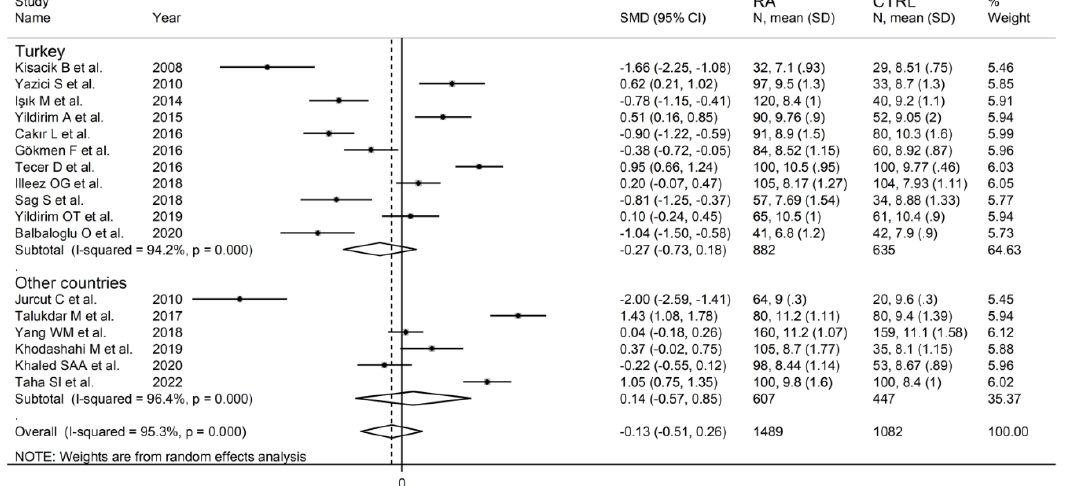
Figure 6. Forest plot of studies examining the mean platelet volume in patients with rheumatoid arthritis and healthy controls according to the country where the study was conducted.